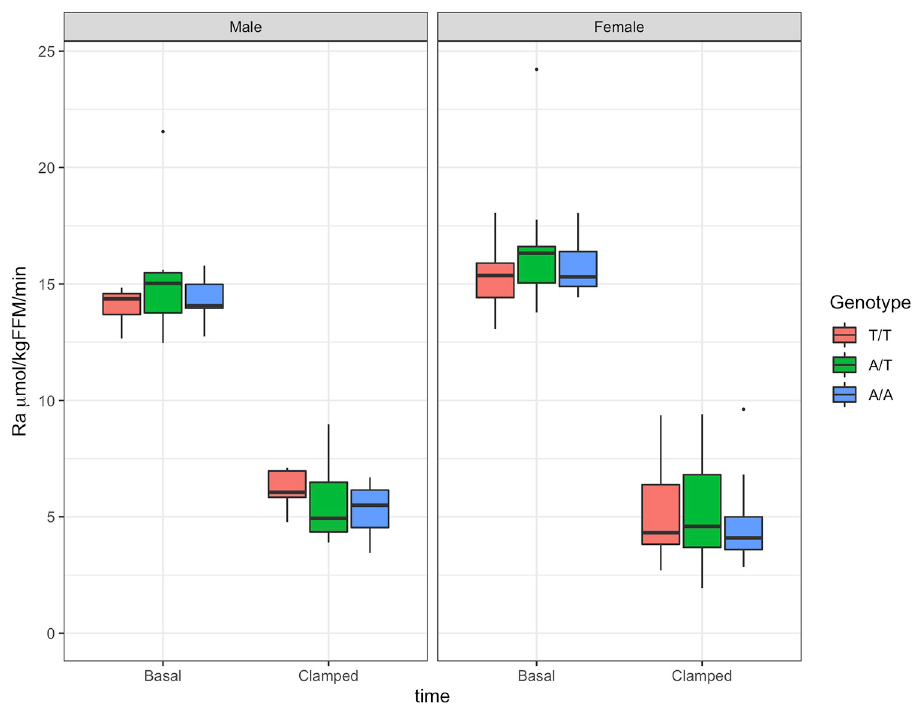
Fig 4. Endogenous glucose production (EGP) by sex and genotype. EGP at basal time and in response to insulin infusion of 0.3 mU � kg -1 � min -1 . Boxplots for males in left panel and for females in right panel.